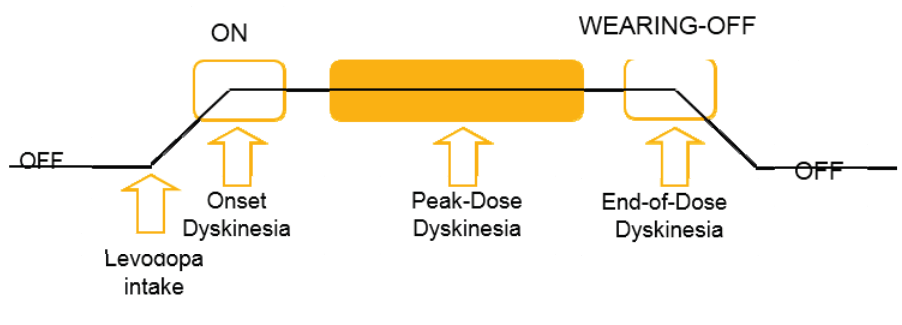
Figure 1. Schematic diagram illustrating the motor fluctuations cycle of